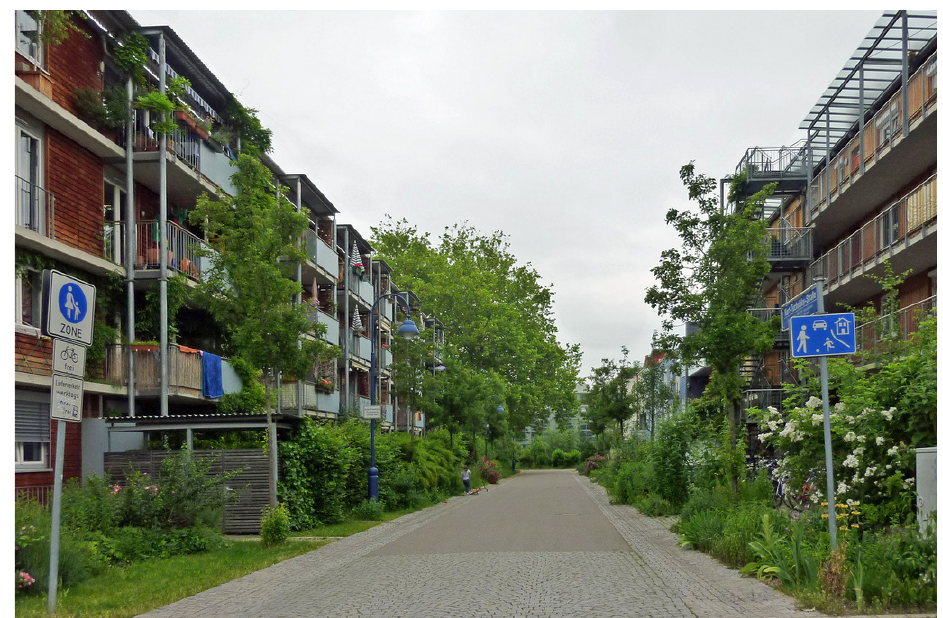
Figure 1. Vauban housing court in 2011 (Payton Chung,